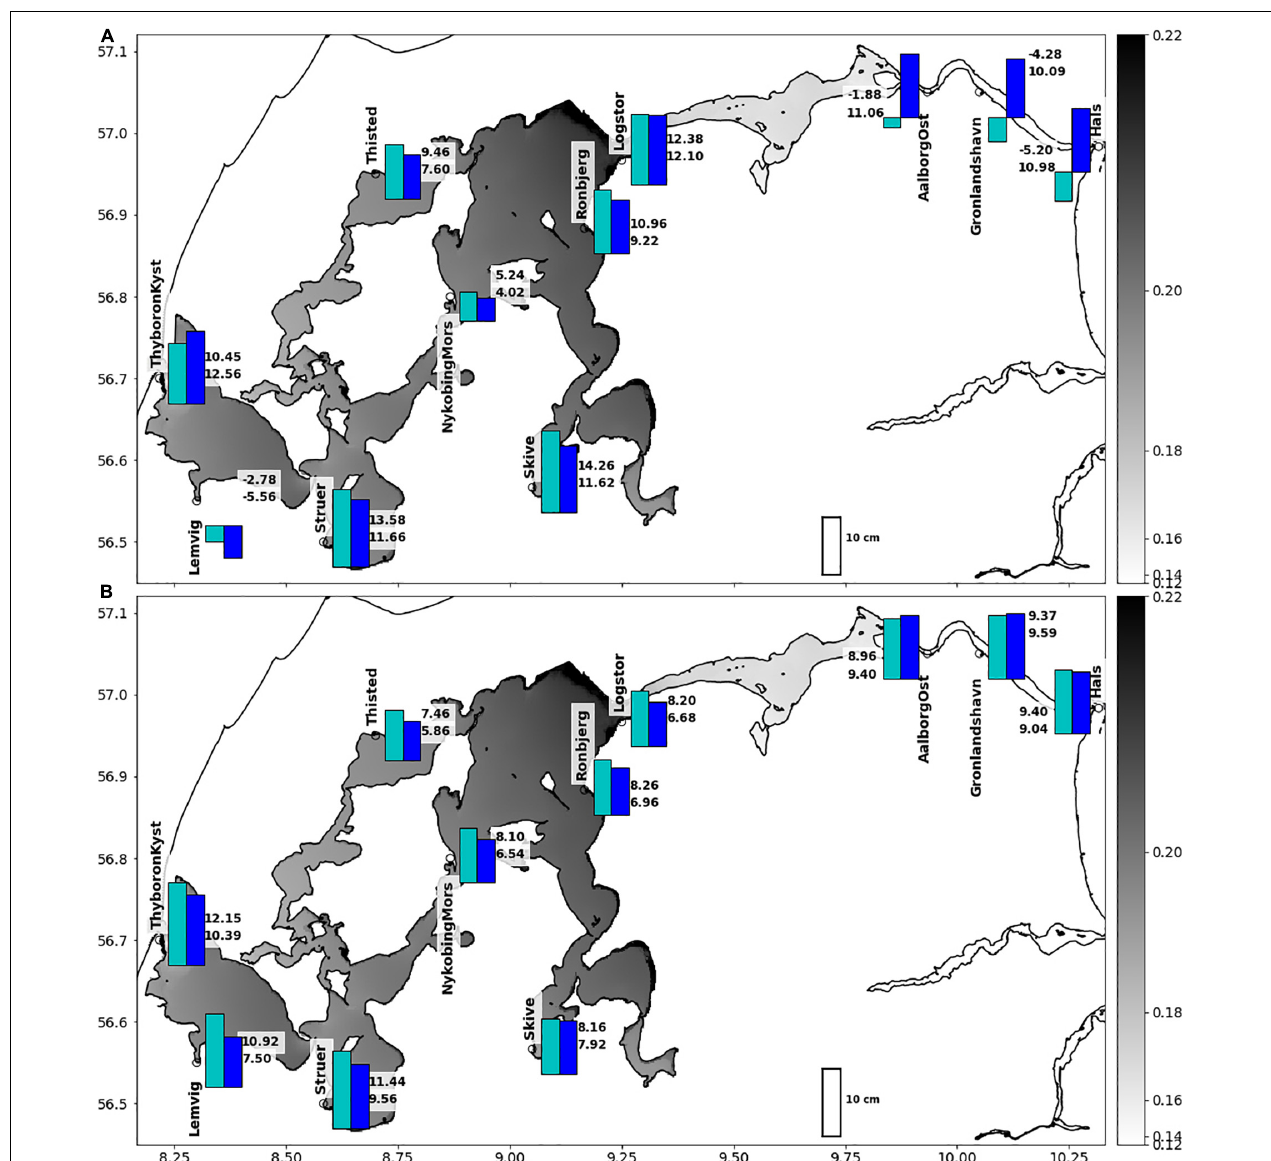
FIGURE 3 | Bias (A) and centered Root-Mean-Square-Error (cRMSE) (B) of DMI’s operational stand-alone model (light blue, upper number) and two-way nested model (dark blue, lower number). Units are given in centimeter. The shading shows the modeled 5 year mean sea-level. Restricted water transport through narrows at Oddesund (near Struer) and Agersund (near Løgstør) leads to a higher mean sea level in the western part of the